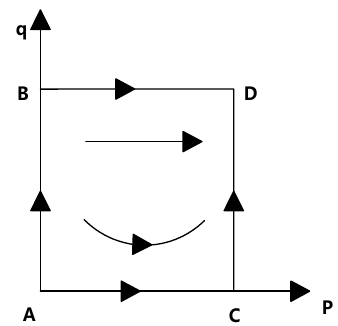
Figure 5. The evolution of phase diagrams in Case 3 ( P S ( 1 − γ ) − T <